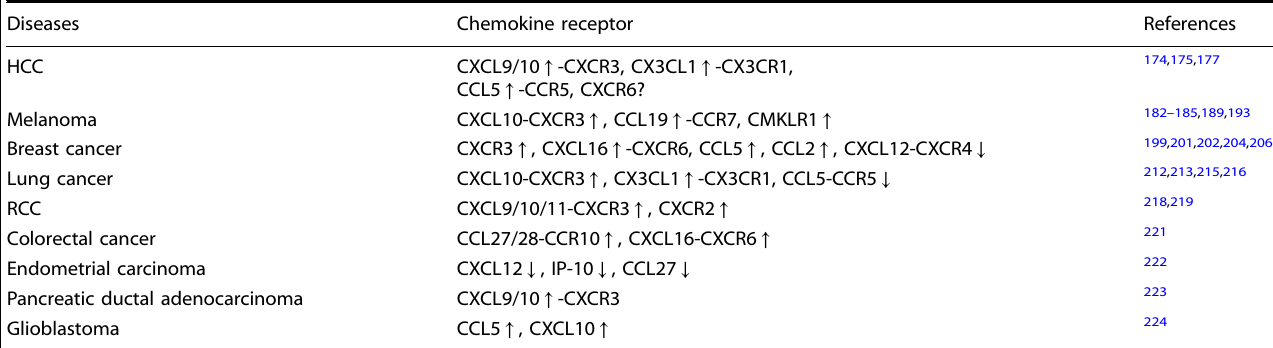
Table 1. Chemokine receptors affect the traf fi cking of NK cells into tumors Diseases Chemokine